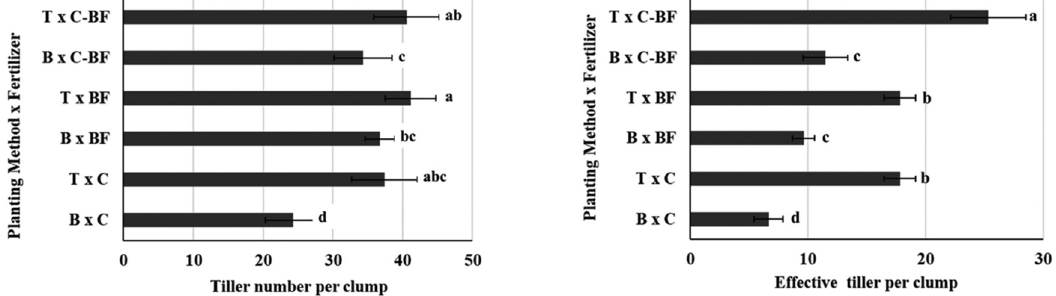
Figure 4: The tiller and e ff ective tiller number of a rice clump with di ff erent planting methods and fertilizer combination treatments 60 days after planting. The planting methods were transplanting ( T ) and broadcasting ( B ) . Fertilizer combination composed of NPK and urea ( control, C ) ; NPK, urea, biofertilizer ( BF ) ; NPK, urea, compost and biofertilizer ( C - BF ) . Error bars represent the standard error of the mean. Di ff erent letters indicate signi fi cantly di ff erent based on the LSD test ( p ≤ 0.05 ) .